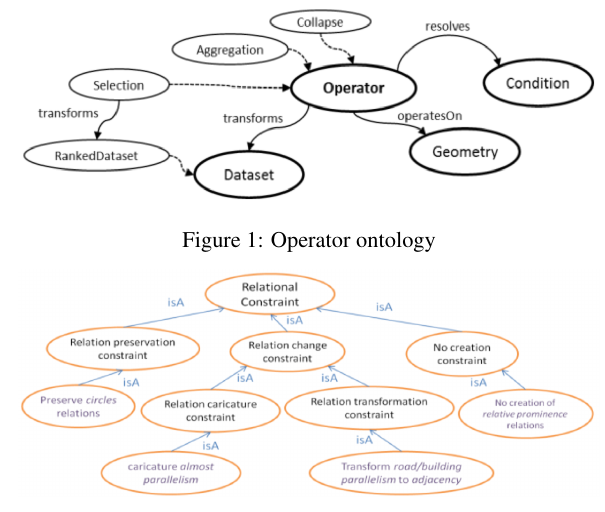
Figure 2: Relational constraint